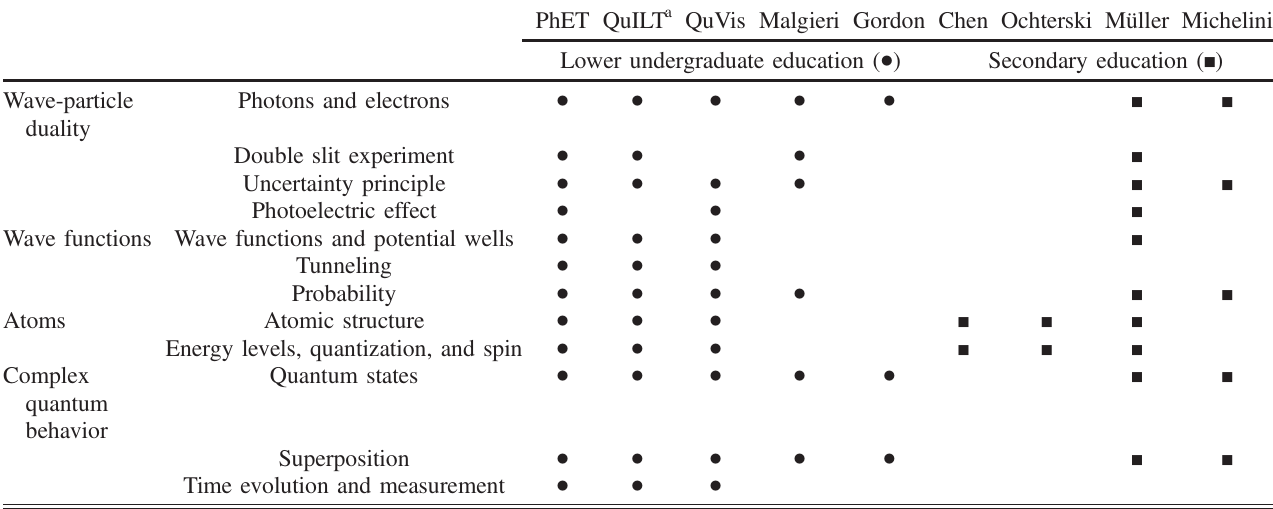
TABLE VI. Overview of quantum mechanical topics covered by the multimedia applications.